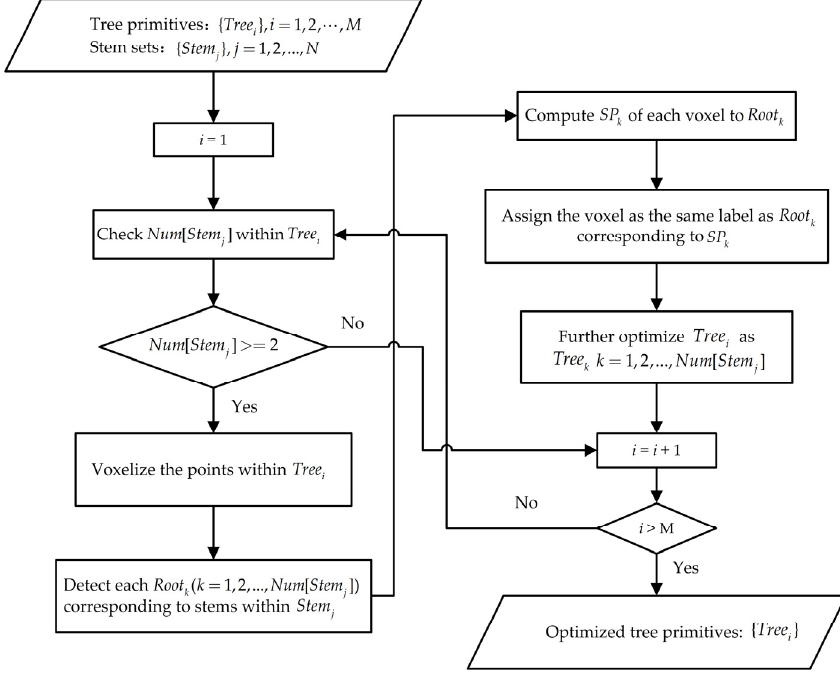
Figure 7. The flowchart of individual tree optimization based on the shortest path analysis.